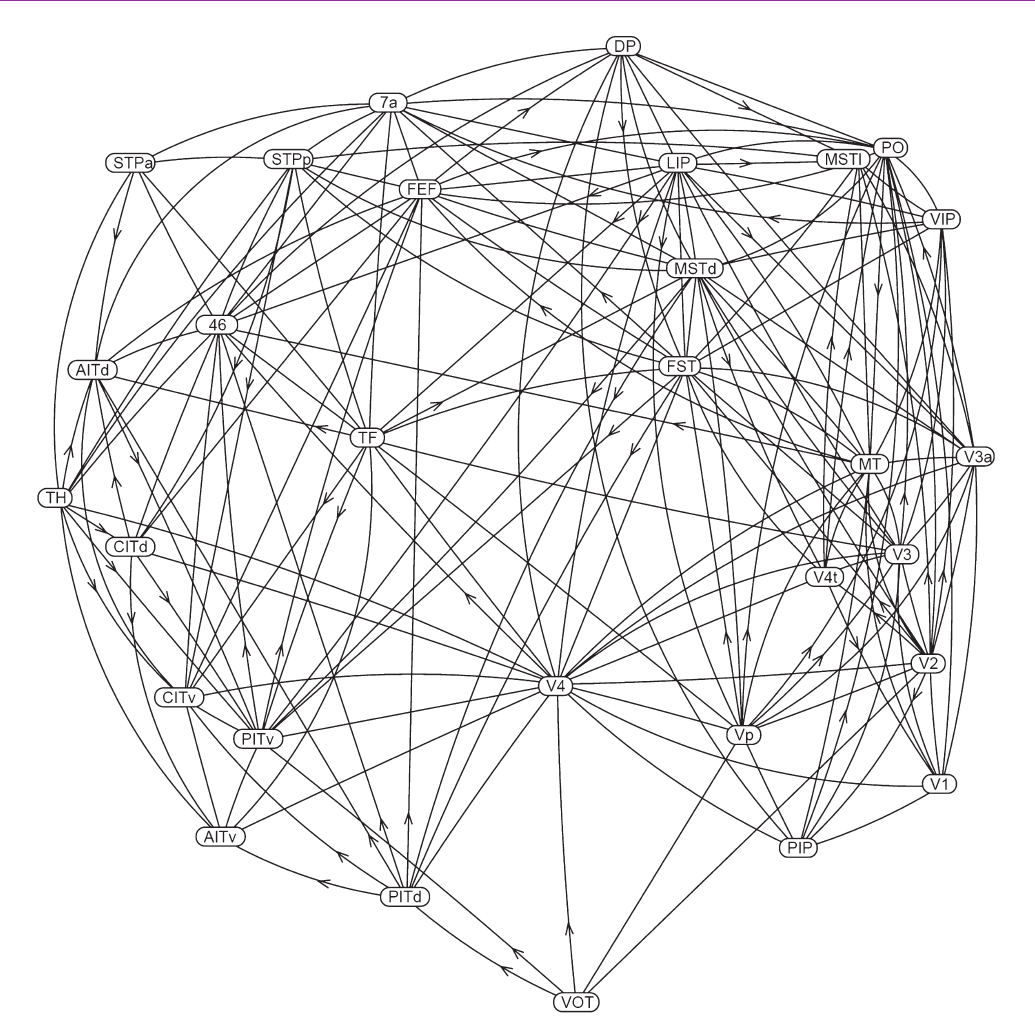
Figure 1. Diagram portraying the directed graph representing the Y92 network. Only neuronal connections that are known to exist are drawn. The positions of the nodes were obtained by multidimensional scaling (MDS) using Kruskal’s method using the software package Systat 10 on the correlations between the connectivity vectors for each node as described in full detail in Ko¨tter and Stephan,